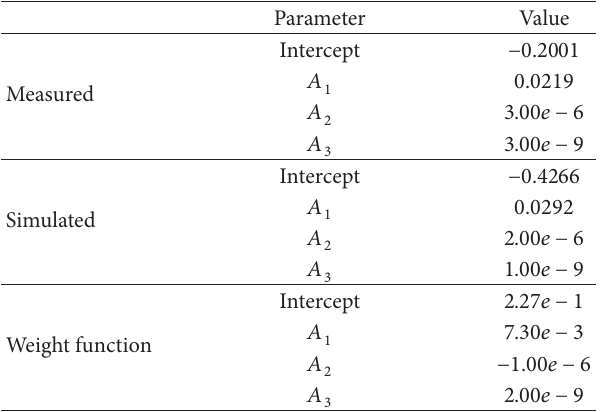
Table 2: The data used in our developed model. Measured